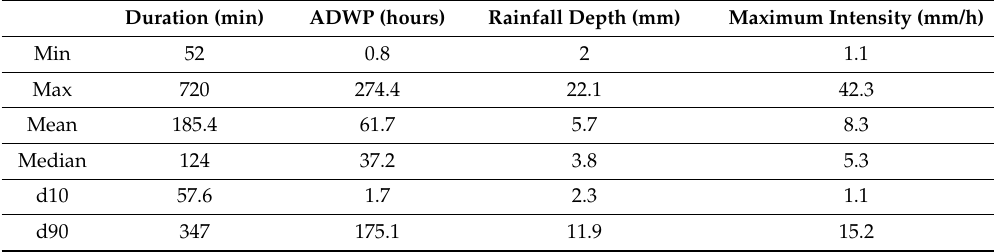
Table A1. Characteristics of the simulated rainfall events for the calibration period from October 2014 until January 2015. (ADWP is the antecedent dry weather